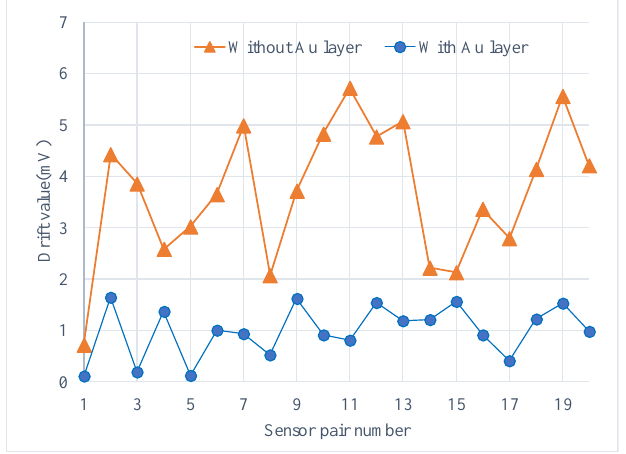
Figure 7. Comparison of sensors with and without an Au layer. Materials 2018 , 11 , 163